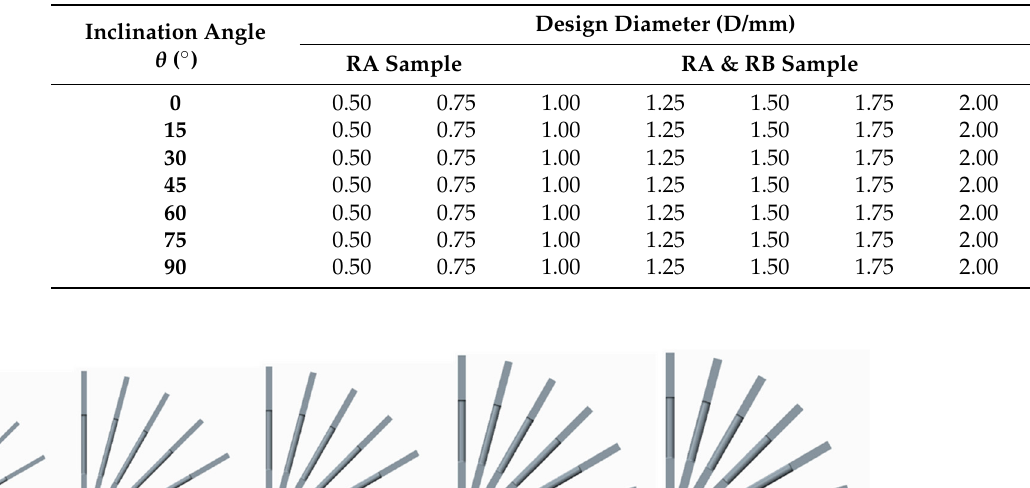
Figure 3. RB sample: ( a ) the CAD model of RB sample for rod diameter of 1.00–2.00 mm in increments of 0.25 mm and ( b ) the RB Sample manufactured by SLM. Table 1. The design parameter of the sample.